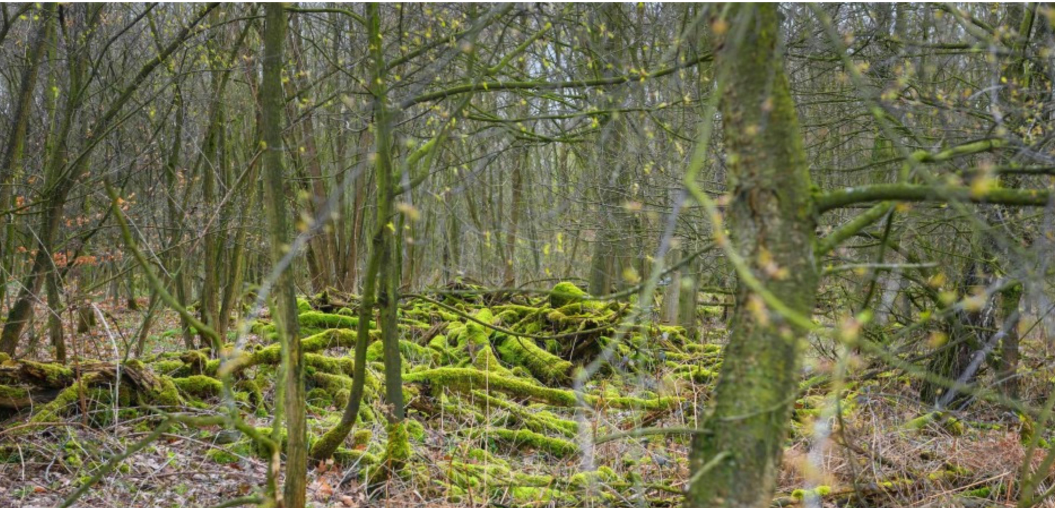
Figure 12. Urban wilderness in the post-industrial Rheinelbe forest complemented by design elements (S. Pauleit). Funding for design and environmental activities was provided through IBA Emscher Park. Source: www.waz.de/staedte/gelsenkirchen/ auf-jeden-gelsenkirchener-buerger-kommen-33-quadratmeter-wald-id216746705.html (accessed on 23 May